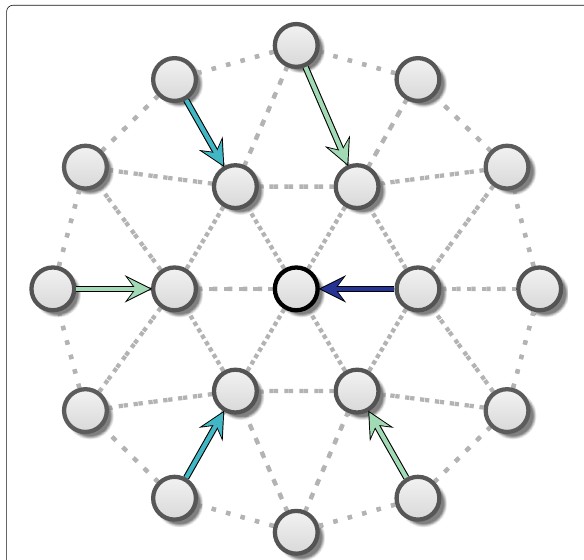
Fig. 11 A possible coloring for a set of conflicting links